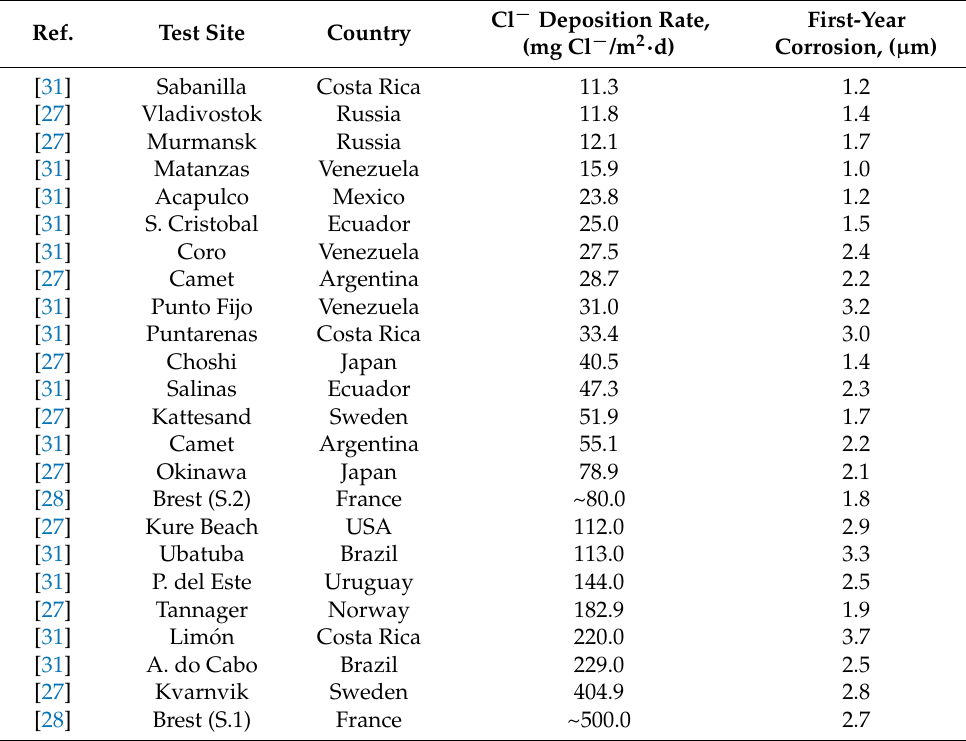
Table 1. First-year worldwide corrosion of copper in pure marine atmospheres, Cl − : ≥ 10 mg/m 2 · day; SO 2 : ≤ 10 mg/m 2 ·